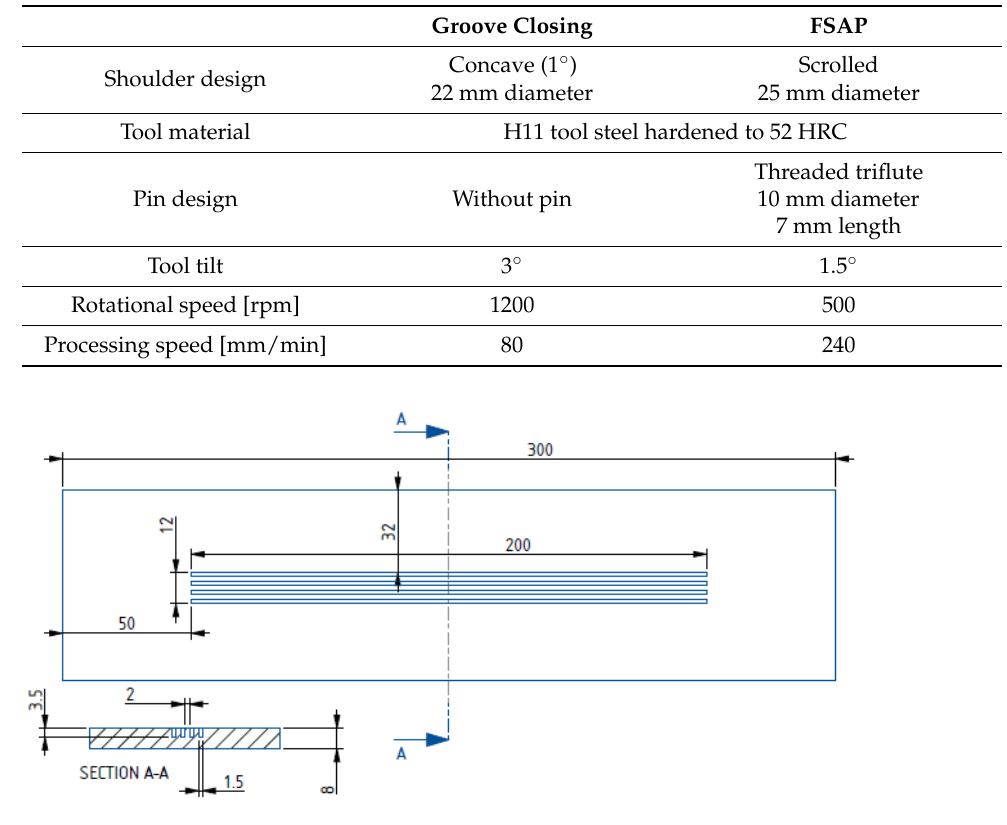
Figure 1. Design of processed plate and detail of groove